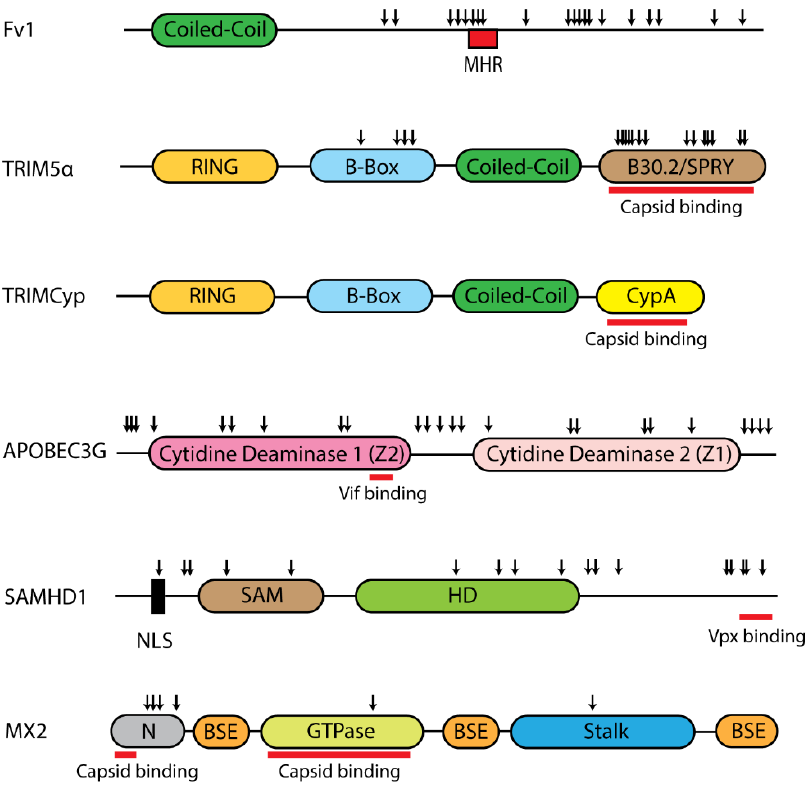
Figure 3. Domain organization of retroviral post-entry restriction factors . Schematic representation identifies positively selected residues (down arrows) found through analyses of Fv1 in rodents and primate genes for TRIM5α, APOBEC3G, SAMHD1 and MX2 [64–68]. The red bars indicate the binding regions for Vif in APOBEC3G, Vpx in SAMHDI and capsid in TRIM5α, TRIMCyp and MX2 [69–74]. MHR, major homology region; CypA, cyclophilin A; BSE, bundle signaling element; NLS, nuclear localization signal; N, unstructured amino terminal domain.